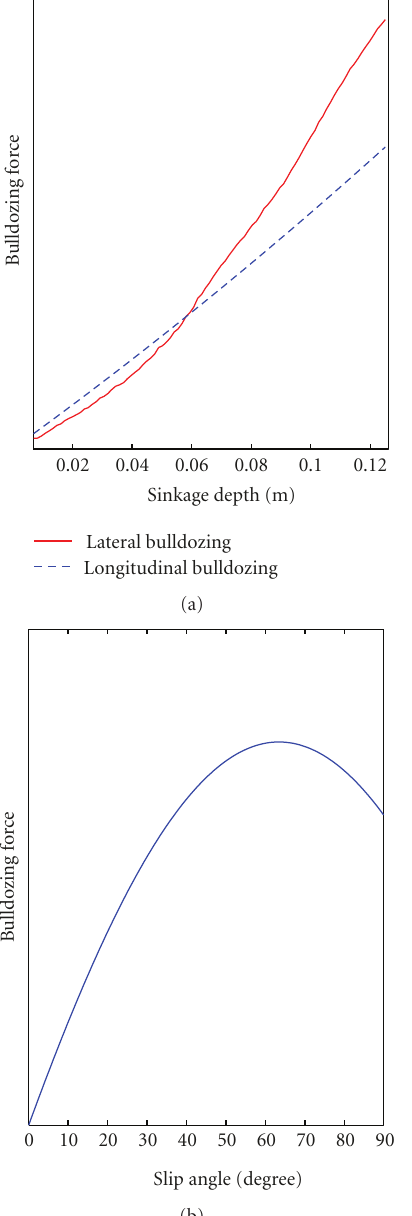
Figure 9: Bulldozing resistance force as a function of sinkage (a) and slip angle β (b).